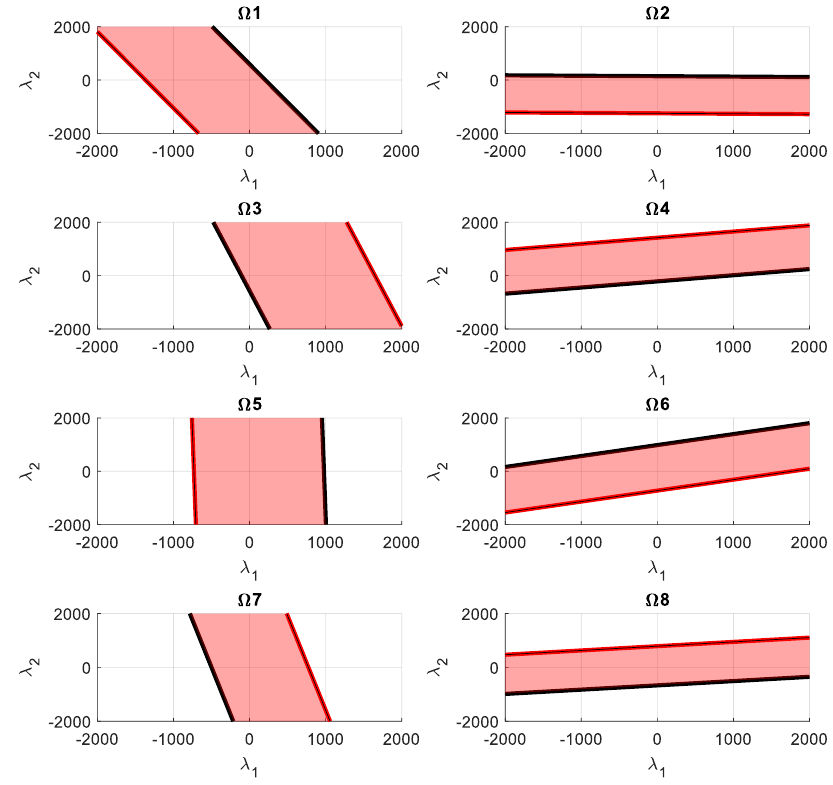
Figure 6. Red region ( Ω i ) : feasible region in the nullspace that provides a cable tension inside the allowable value. Black line ( Λ imin ) : region where one or more cables achieve the minimum allowable tension value. Red line ( Λ imax ) : region where one or more cables achieve the maximum allowable tension value.